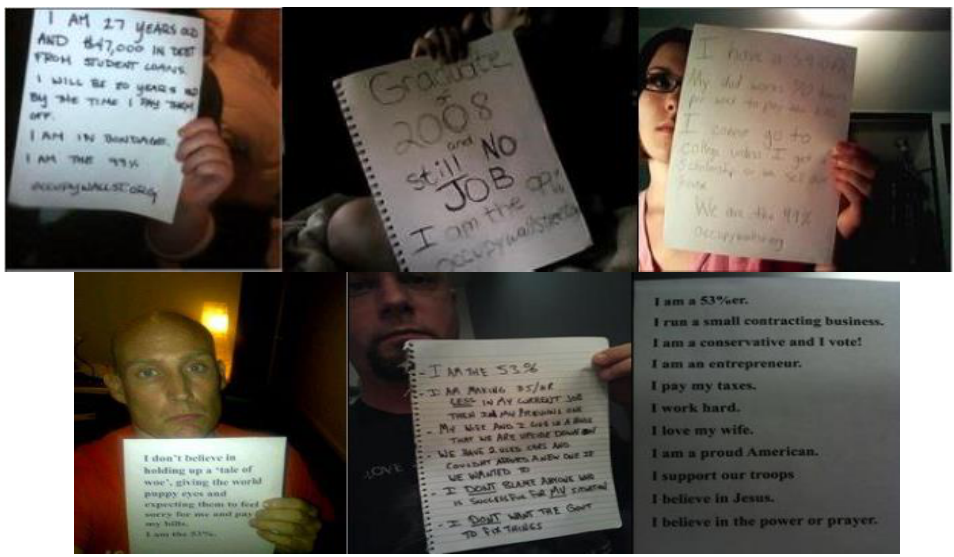
Figure 1 . “I am the 99%” memes (top) and “I am the 53%” memes